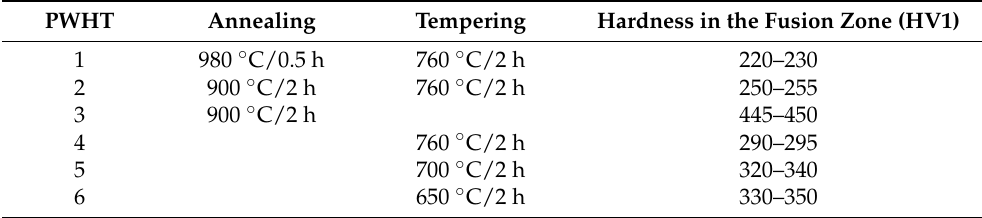
Table 2. PWHTs applied to 5- and 10-mm welds (TIG, EB, and Laser). PWHT Annealing